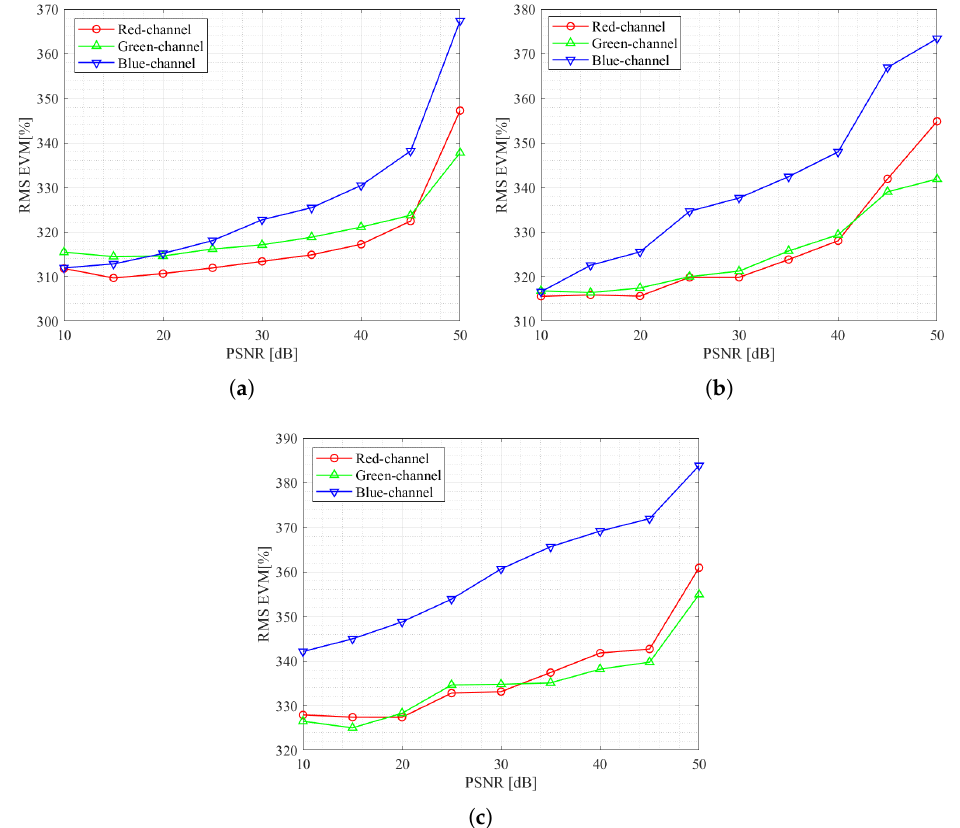
Figure 9. EVM performance according to PSNR and transmit image size. ( a ) 128 × 128 pixel size. ( b ) 256 × 256 pixel size. ( c ) 512 × 512 pixel